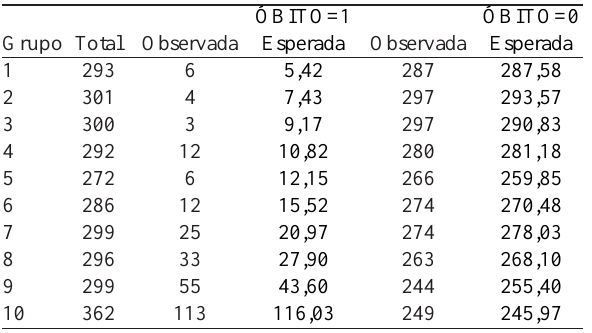
Tabela 3. Mortalidade observada e esperada mediante uso do 2000BP como variável preditora nos grupos definidos pelo teste